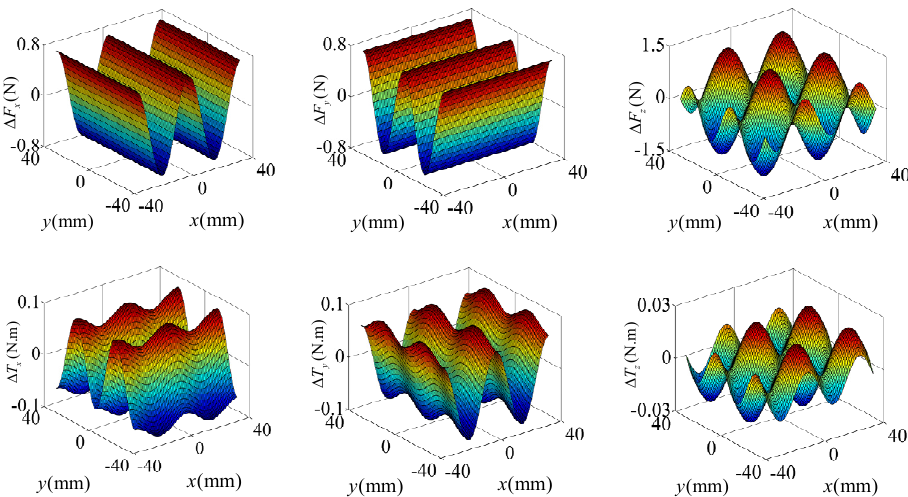
Figure 5. The force and torque errors between the deduced model and the harmonic model.